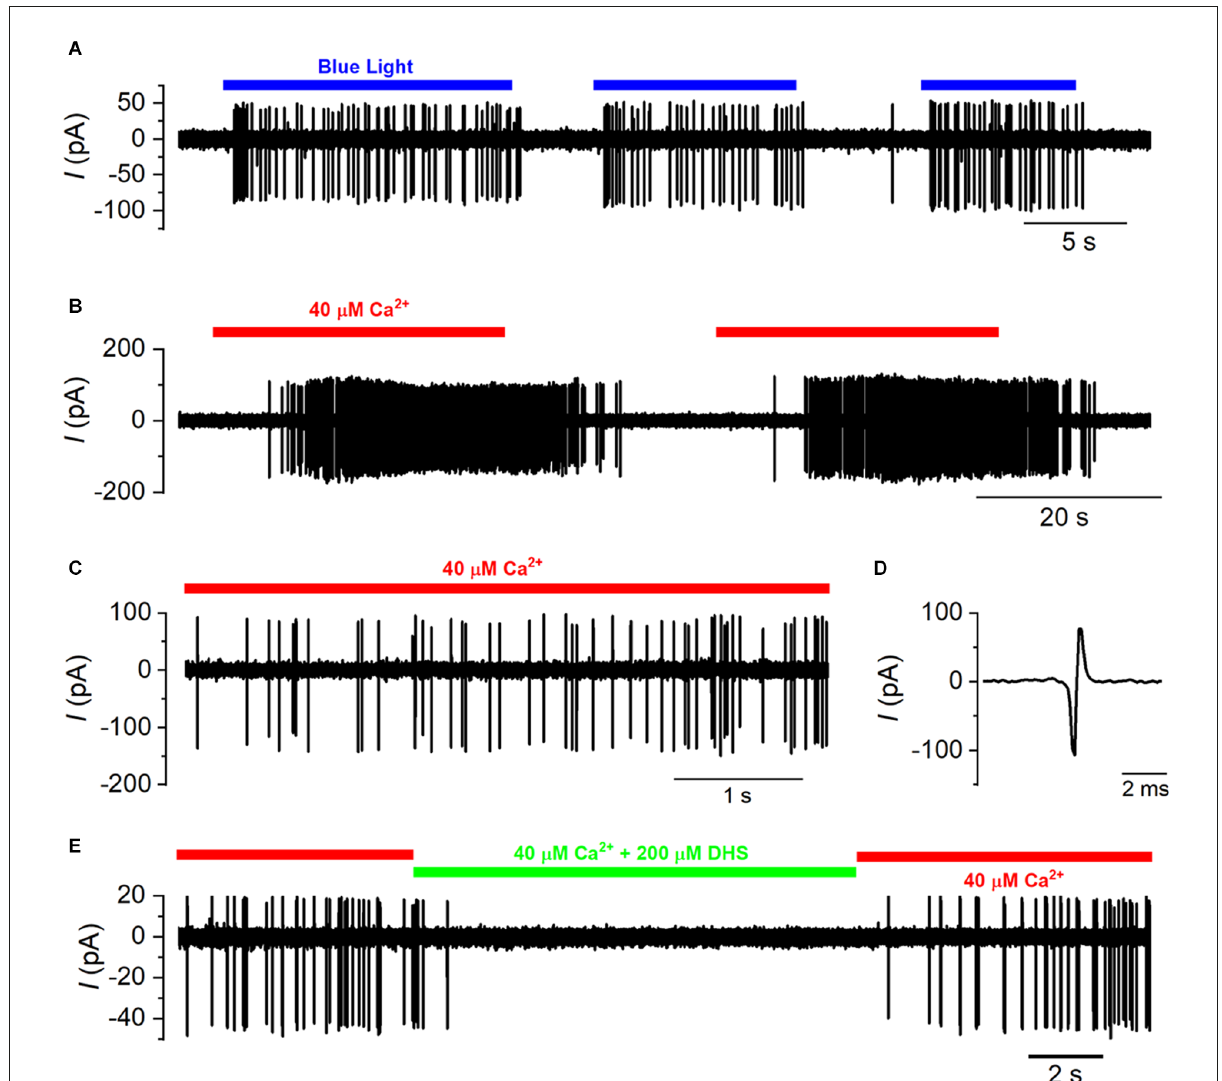
FIGURE6 Spiking activity in the calyx is driven by type-I hair cell depolarization. (A) A typical example of a cell-attached recording from a calyx in the mouse utricle where spiking activity was elicited in ChR2 fl/fl ; Otof-cre + / − mice by the repeated exposure of the utricle to blue light. (B) Calyx spiking was elicited in wild-type mice by the local perfusion of an extracellular solution containing 40 µ M Ca 2+ (indicated by the red bar) instead of normal extracellular solution that contained 1.3 mM Ca 2+ . Spiking activity was repeatedly elicited by the low Ca 2+ solution. (C) Expanded view of the spiking activity in the presence of 40 µ M Ca 2+ from panel (B) . (D) A single extracellular spike that results from an action potential within the calyx that causes a biphasic current transient that is recorded from the membrane within the recording pipette. (E) Calyx spiking activity triggered by 40 µ M Ca 2+ is reversibly suppressed by the additional perfusion of the MET channel blocker DHS (200 µ M; indicated by the green